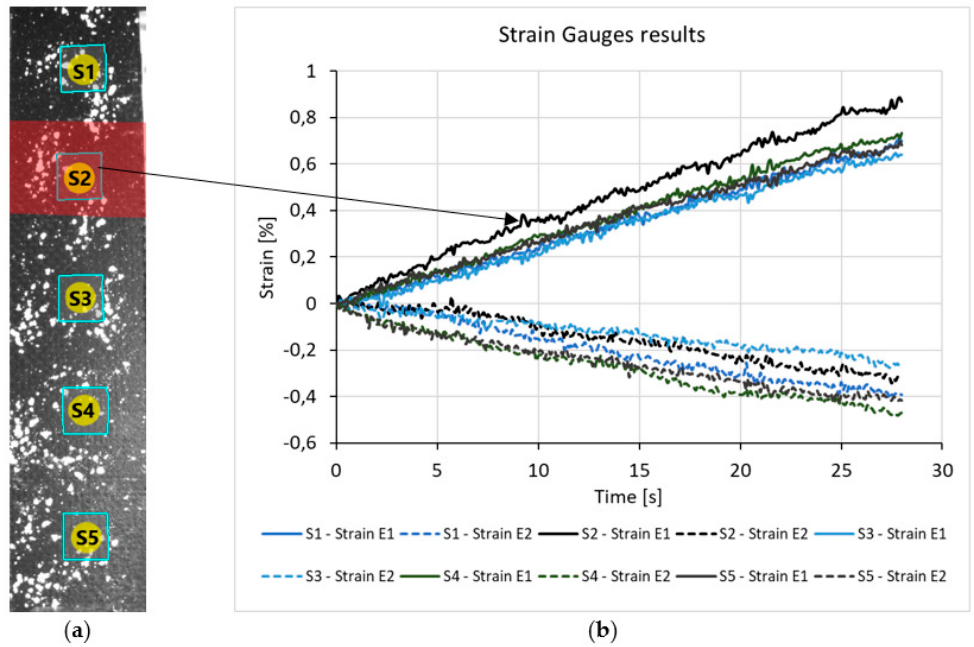
Figure 3. ( a ) Location of strain gauges in the first specimen ( b ) strain-frame diagram from virtual strain gauges.